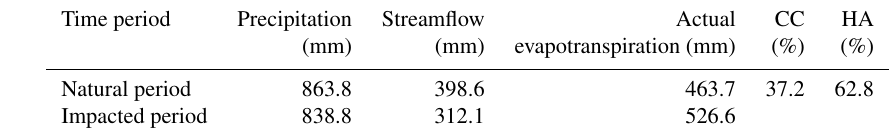
Table 6. CR of climate change (CC) and human activities (HAs) calculated by the Budyko framework.